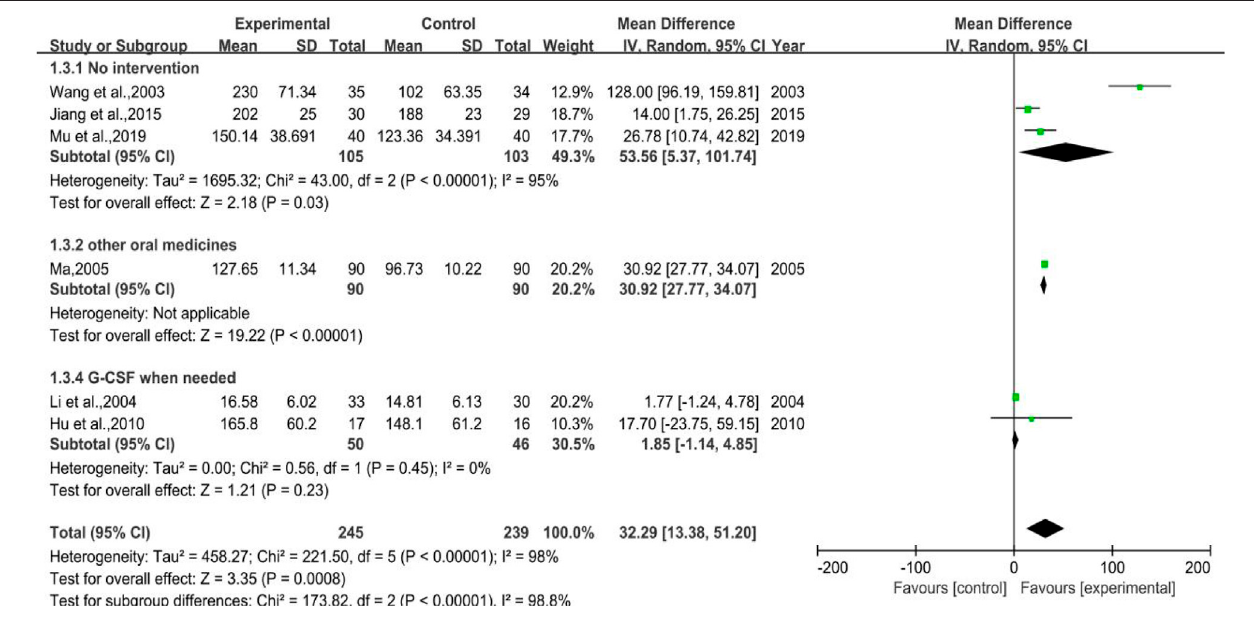
FIGURE 5 | The forest plot of platelet count in preventive medication.